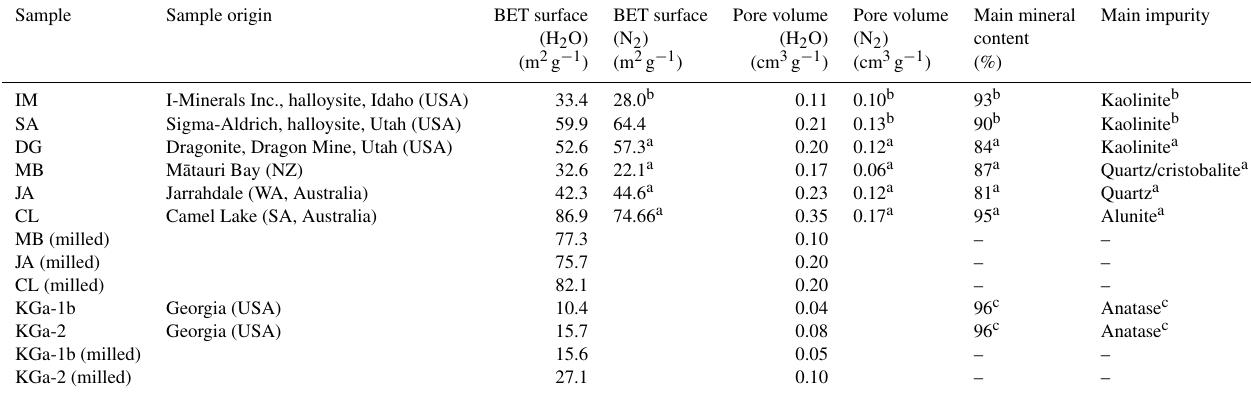
Table 1. Overview of sample parameters with the sample origin, specific surface area, and specific pore volume (determined via N 2 -BET (Brunauer–Emmett–Teller) and H 2 O-DVS) from this study and from the referenced literature, together with content of main mineral and main